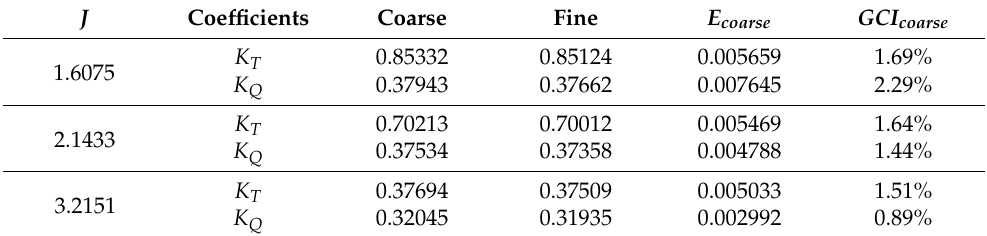
Table 7. GCI of different grid numbers.